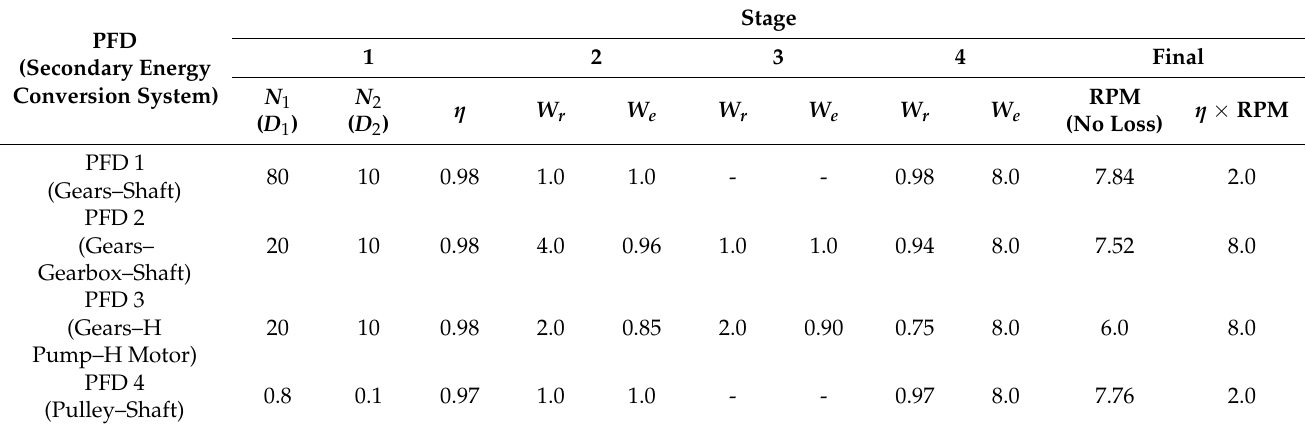
Table 6. Efficiency and RPM of the system having the same rotational increase